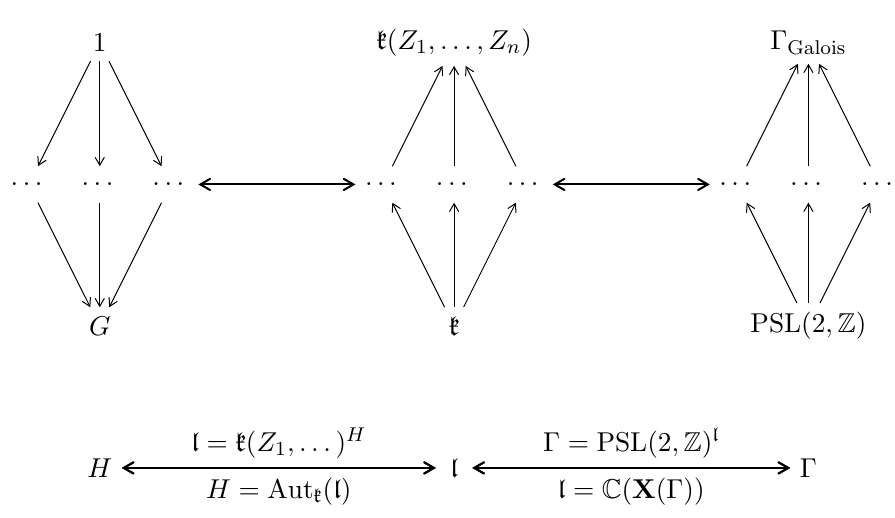
Figure 2 . Schematic Galois correspondence for rings of modular forms. The diagram on the left represents the subgroup structure of G , the middle one the (cid:12)elds of meromorphic functions on modular curves generated by polynomials of the roots of the characteristic polynomial and the diagram on the right represents congruence subgroups that contain (cid:0) Galois . The bottom line gives the explicit bijections between corresponding elements in the di(cid:11)erent